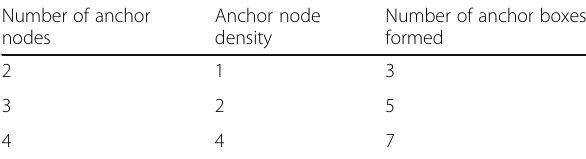
Table 1 Number of anchor boxes formed by mobile